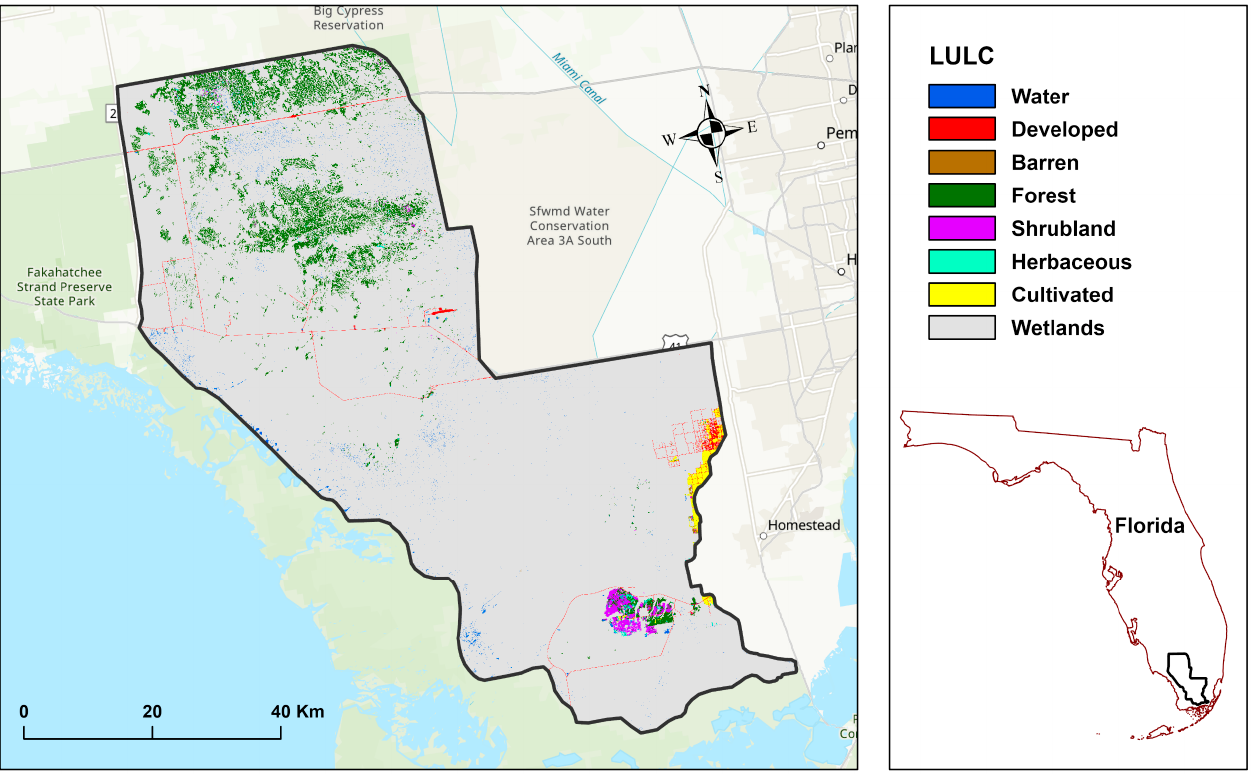
Figure 2. The study area with its land use land cover